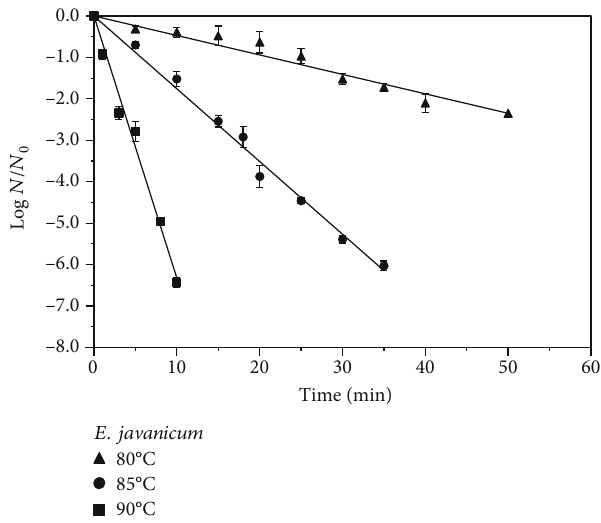
Figure 1: Heat inactivation of Talaromyces fl avus ascospores in guava juice (11.4 ° Brix, pH 4.1) at 80 ° C-90 °